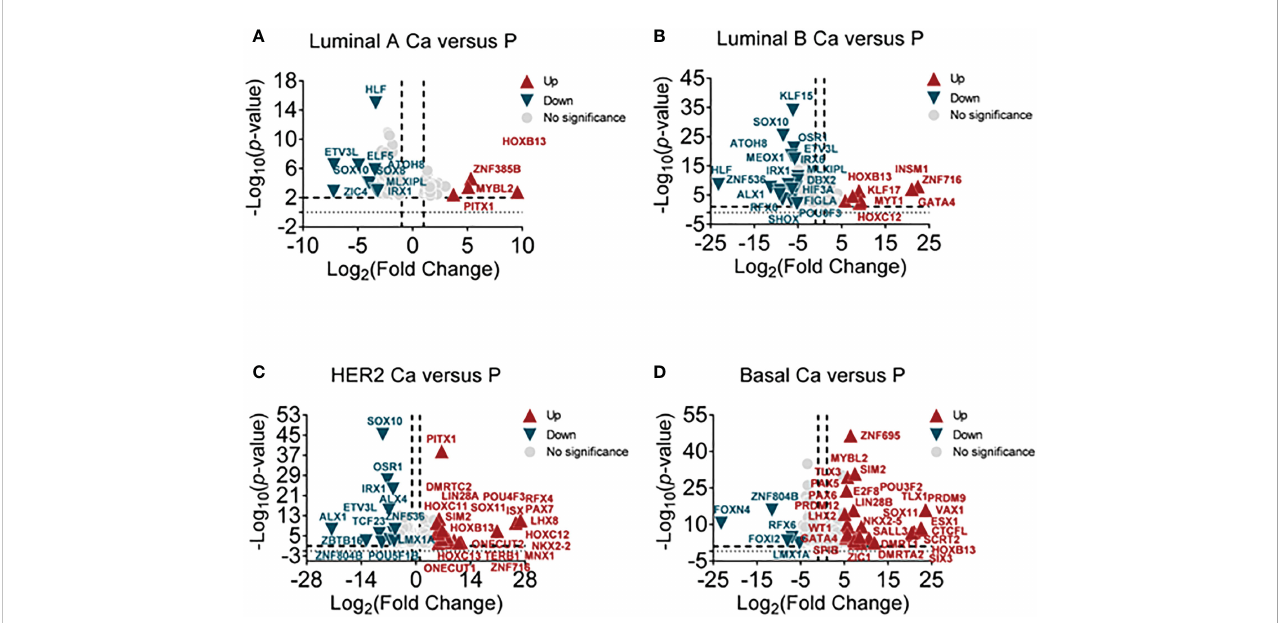
FIGURE 1 Screening differential TFs in breast cancer subtypes by RNA-sequencing. (A) The volcano plot analysis of high and low TFs in the luminal A subtype (luminal A Ca) compared with adjacent tissue (luminal A P) ( n = 3), (B) in luminal B subtype (luminal B Ca) compared with adjacent tissue (luminal B P) ( n = 3), (C) in the HER2 subtype (HER2 Ca) compared with adjacent tissue (HER2 P) ( n = 3), and (D) in basal-like subtype (basal Ca) compared with adjacent tissue (basal P) ( n =